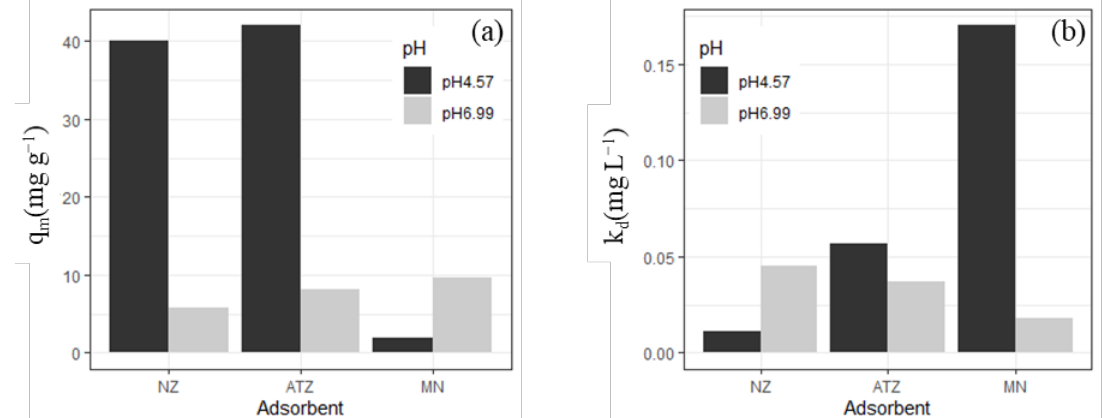
Figure 3. ( a ) Maximum potassium (K) sorption capacity ( q m ) and ( b ) the affinity of the binding sites ( K d ) of the natural zeolite (NZ), ammonium acetate-treated zeolite (ATZ), and manganese nodule (MN) at pH 4.57 and 6.99 derived from the Langmuir isotherm model.